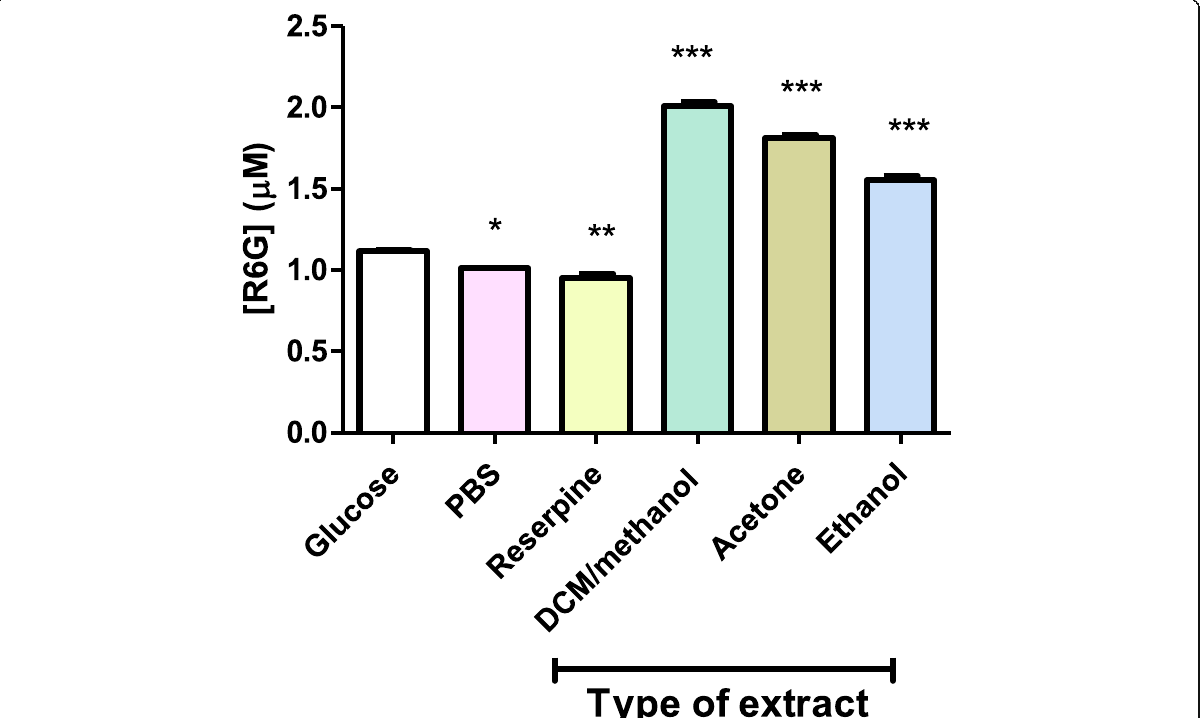
Fig. 3 The effects the acetone, ethanol and DCM/methanol leaf extracts from T . welwitschii on efflux pump activity of the ATCC strain of P. aeruginosa . Cells exposed to glucose served as the positive control where active efflux occurred maximally. The error bars show the standard deviation from the mean of two samples read twice. The asterisks indicate a significant difference from the control with * p < 0.05, ** p < 0.01 and *** p < 0.001